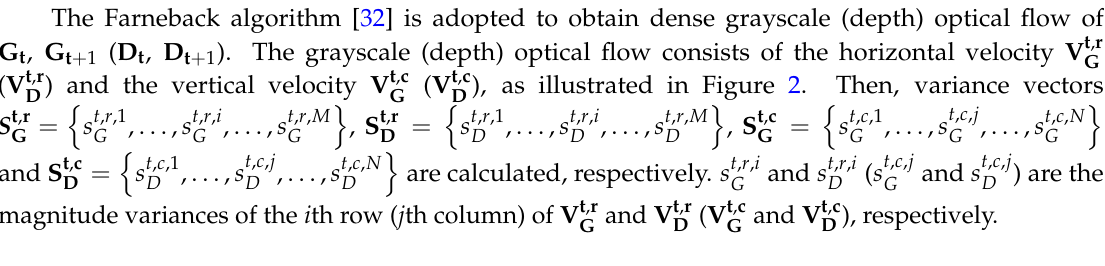
Figure 2. Grayscale and depth optical flow corresponding to Figure 1. ( a ) Grayscale horizontal velocity